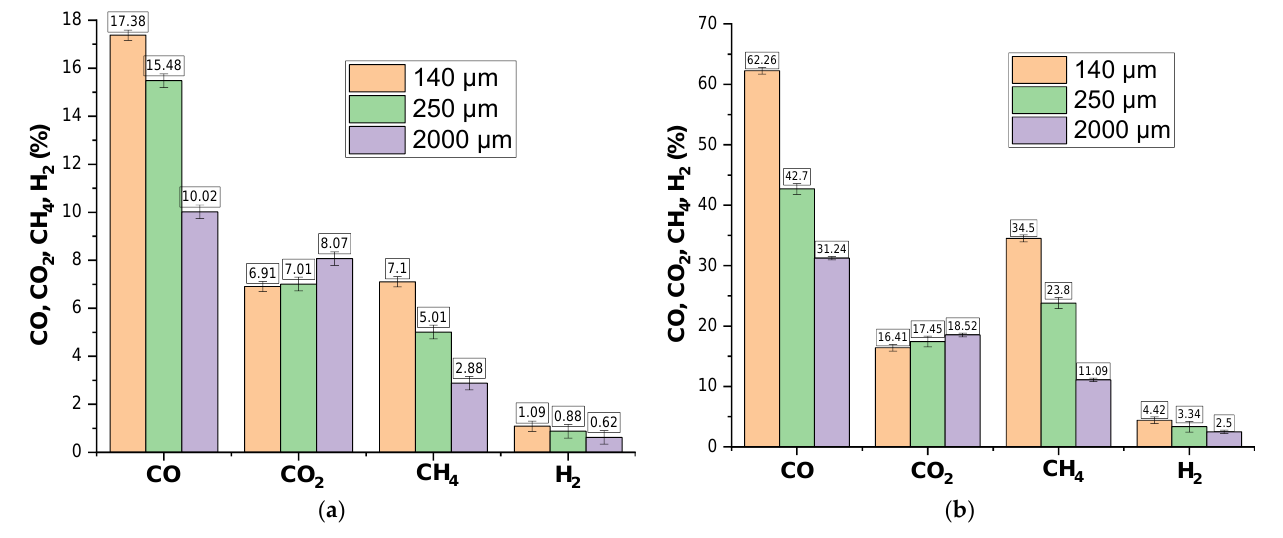
Figure 17. Average ( a ) and maximum ( b ) concentrations of the gas mixture components when varying the average size of biomass particles. Table 7. The yield of the main